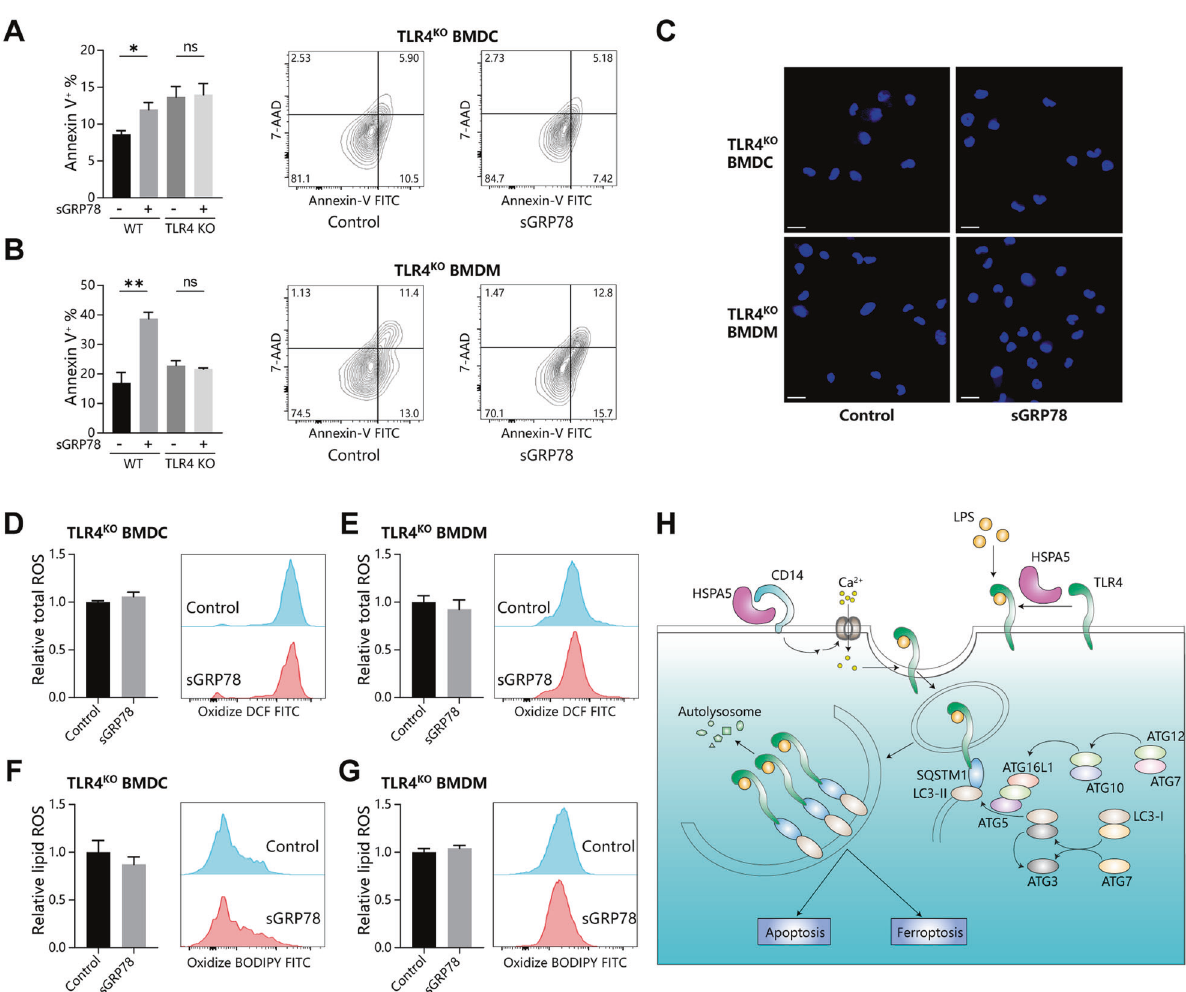
Fig. 7 sGRP78 promotes apoptosis and ferroptosis of myeloid cells. A Cells were treated with LPS, Grp78, Casp3i (20 μ M) and Fer-1 (2 μ M) for 24 h. Then cell death was evaluated through PI staining by FCM. Apoptosis of sGRP78-conditioned cells was analyzed by Hoechst 33258 staining ( B ), DNA ladder ( C ) and Caspase 3 cleavage ( D ). E , F Cells were treated with Grp78, ROS positive control, Fer-1 and Erastin (10 μ M). Intracellular and lipid ROS were detected. G Total iron concentration. H Transmission electron microscopy of BMDCs conditioned with sGRP78 for 48 h. White arrowheads, chromatin condensation; Black arrowheads, shrunken mitochondria; White arrow, the formation of double-membrane vesicles. A minimum of 10 cells per treatment condition was examined. Data are representative of three independent experiments with similar results or mean ± SEM from three independent experiments. * P < 0.05, ** P < 0.01, *** P < 0.001, and **** P <